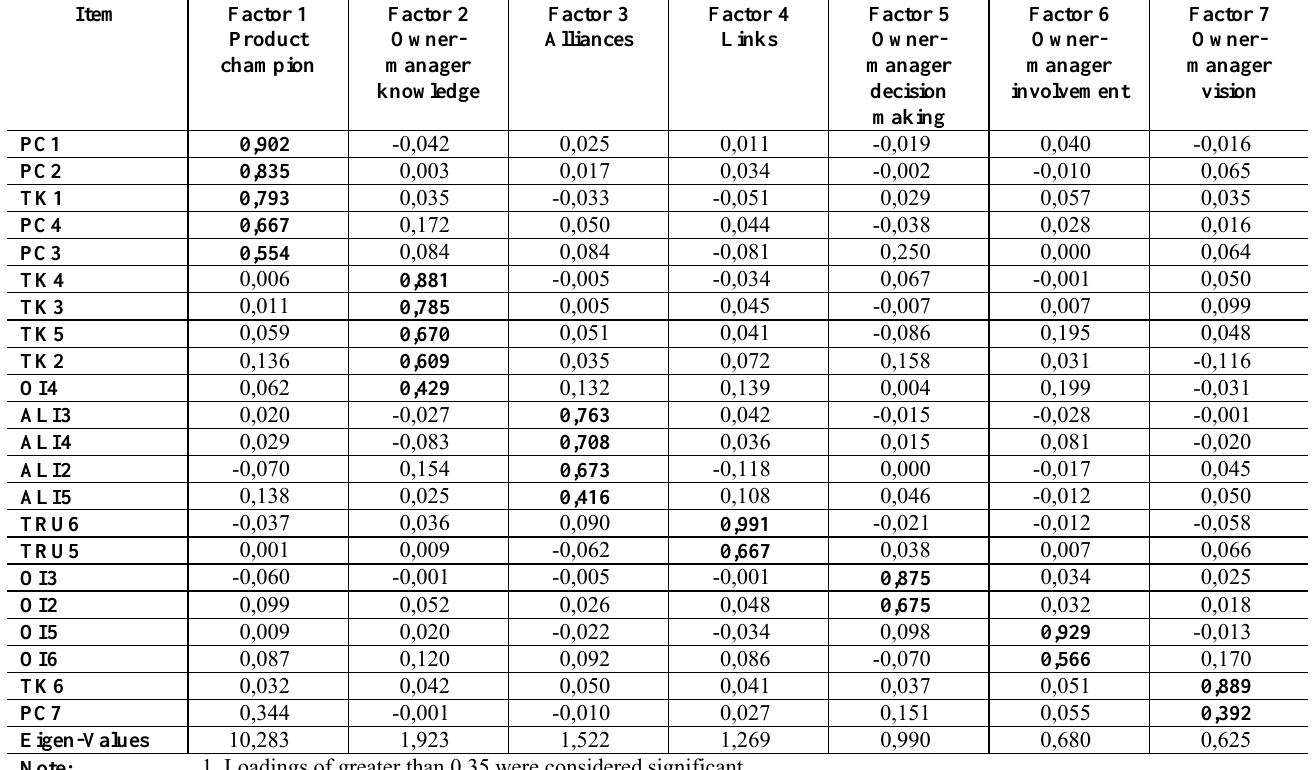
Table 1: Exploratory factor analysis results